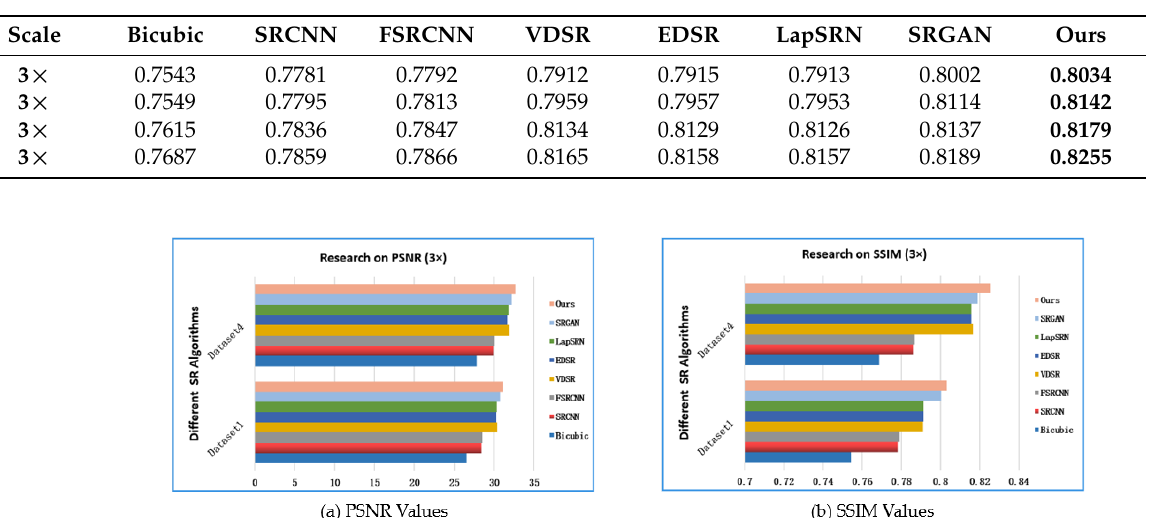
Table 1. Structural analysis of each super-resolution algorithm.